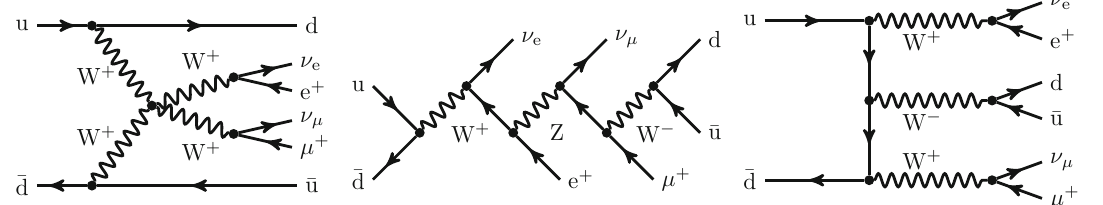
(cid:2) (cid:3) α 6 . In addition to typical VBS contributions (left),